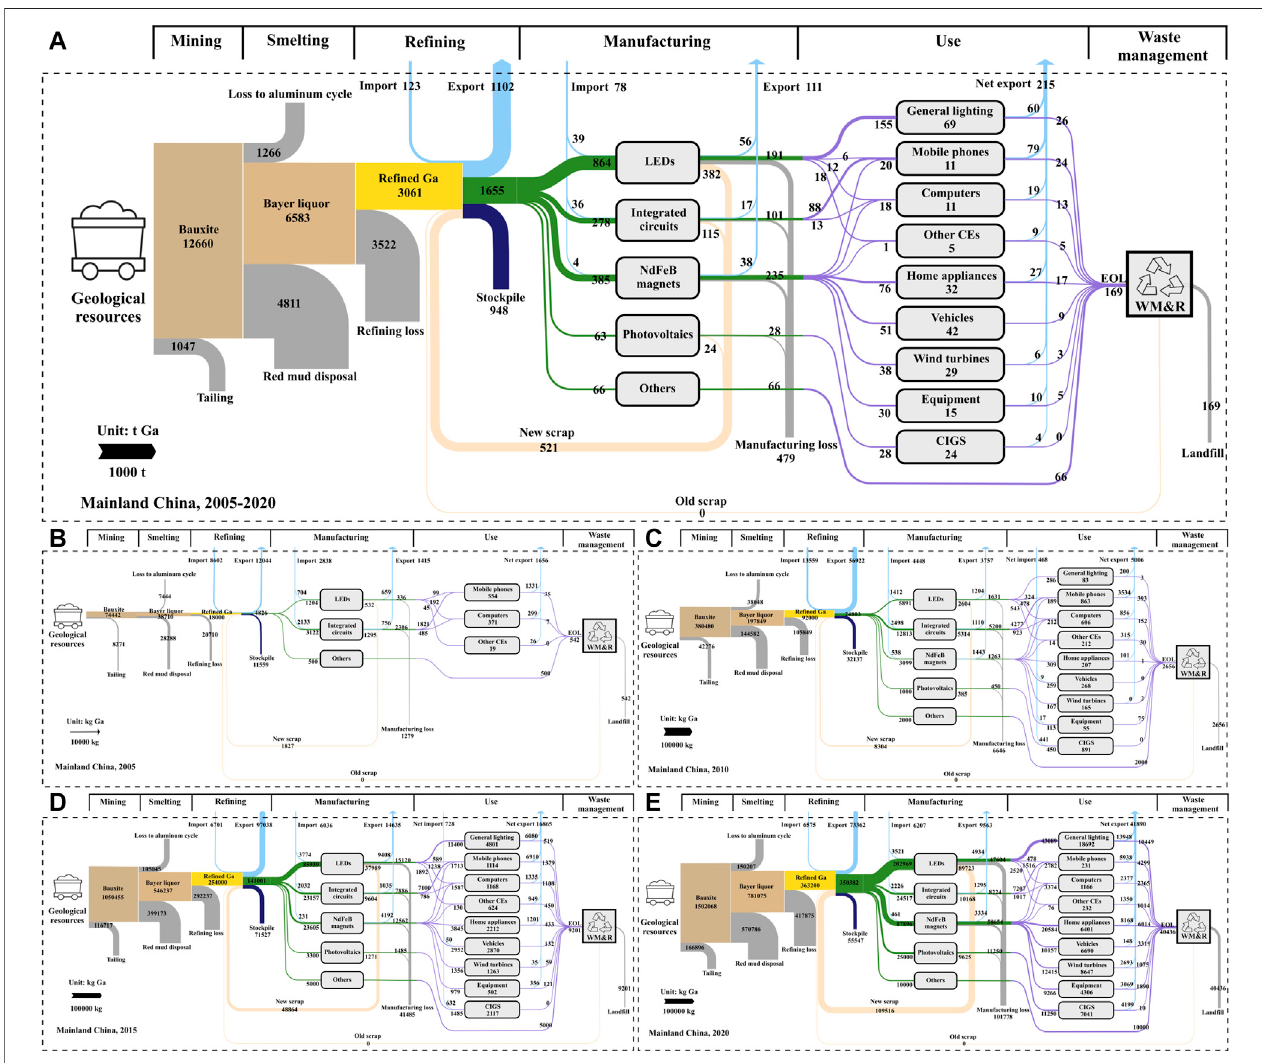
FIGURE 2 | Sankey diagram of (A) the accumulated gallium cycle in China during 2005 – 2020, and four representative 1-year cycles in year (B) 2005 (C) 2010 (D) 2015 (E) 2020 (LED: light-emitting diode; CE: consumer electronic; CIGS: copper indium gallium selenide).